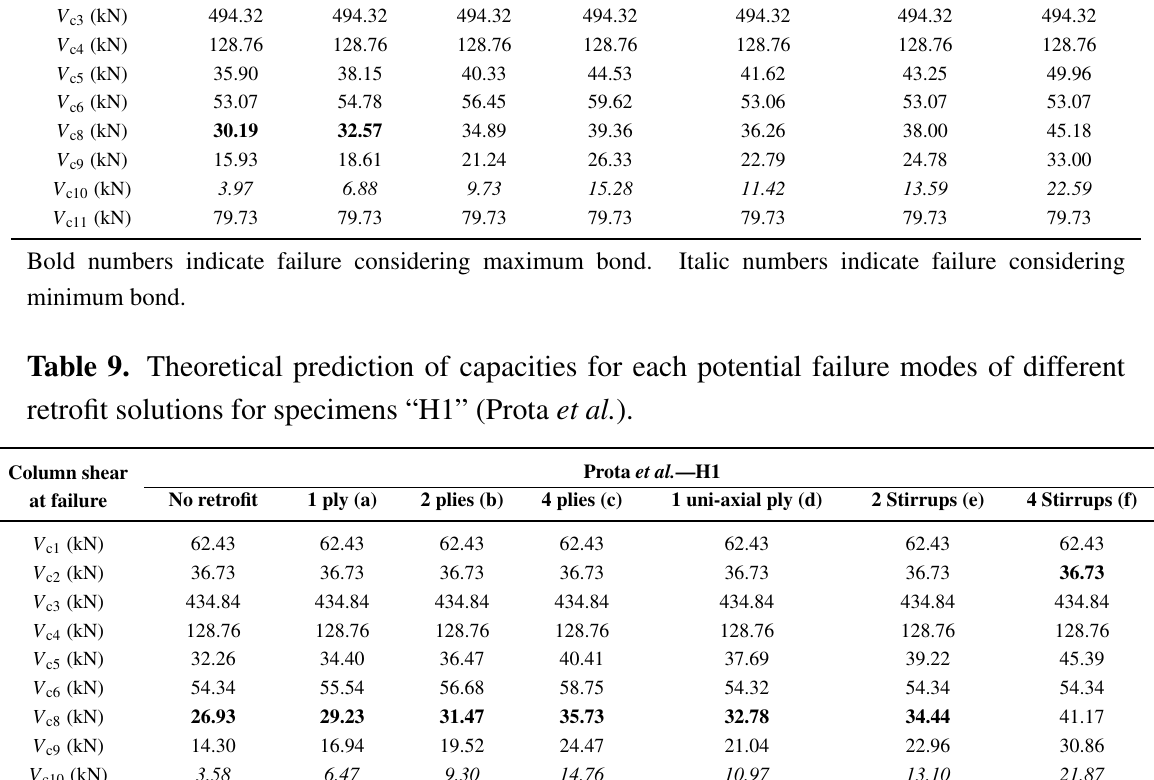
Bold numbers indicate failure considering maximum